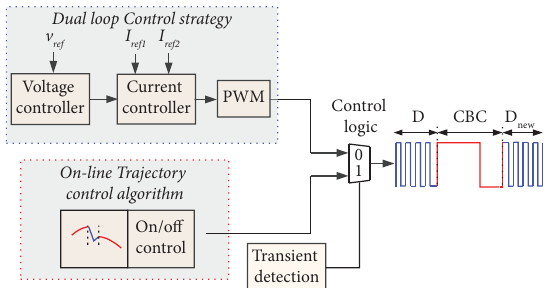
Figure 5: Te on-line trajectory control algorithm in combination with the linear